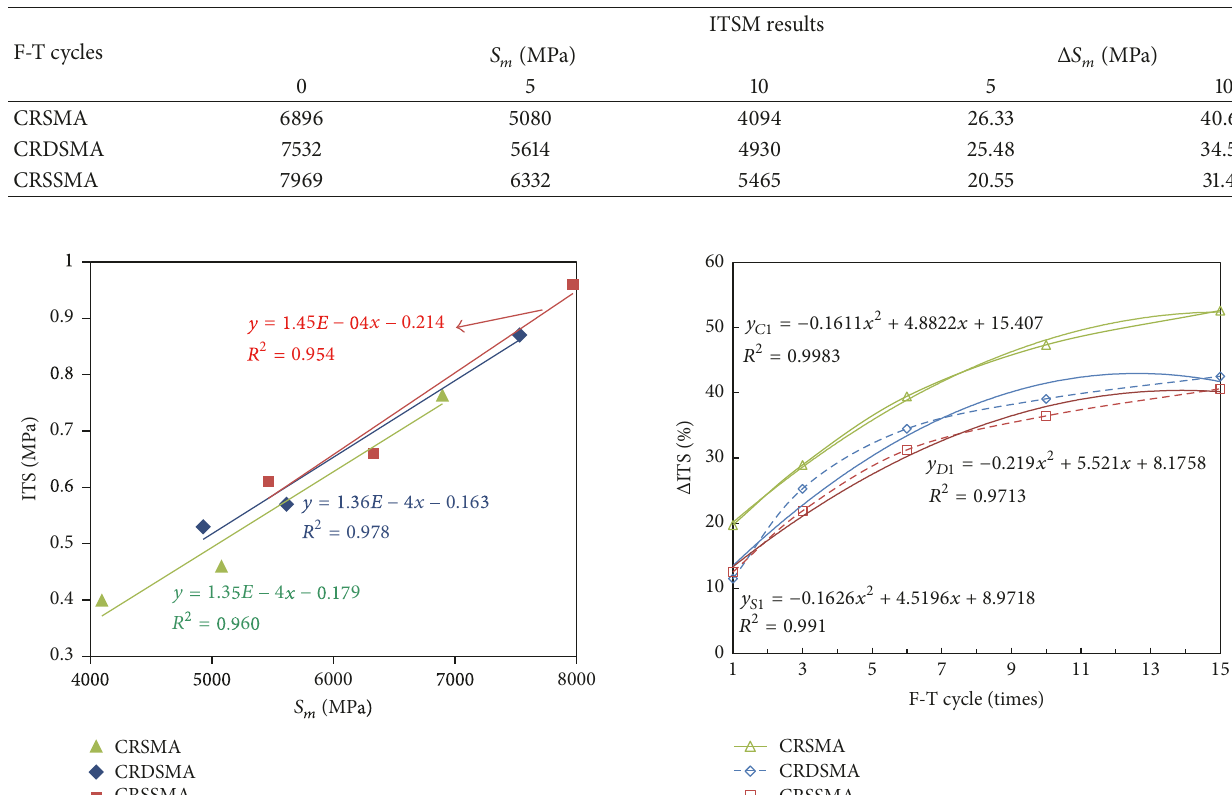
Table 9: 𝑆 𝑚 and Δ𝑆 𝑚 for CRSMA, CRDSMA, and CRSSMA before and after F-T cycles.